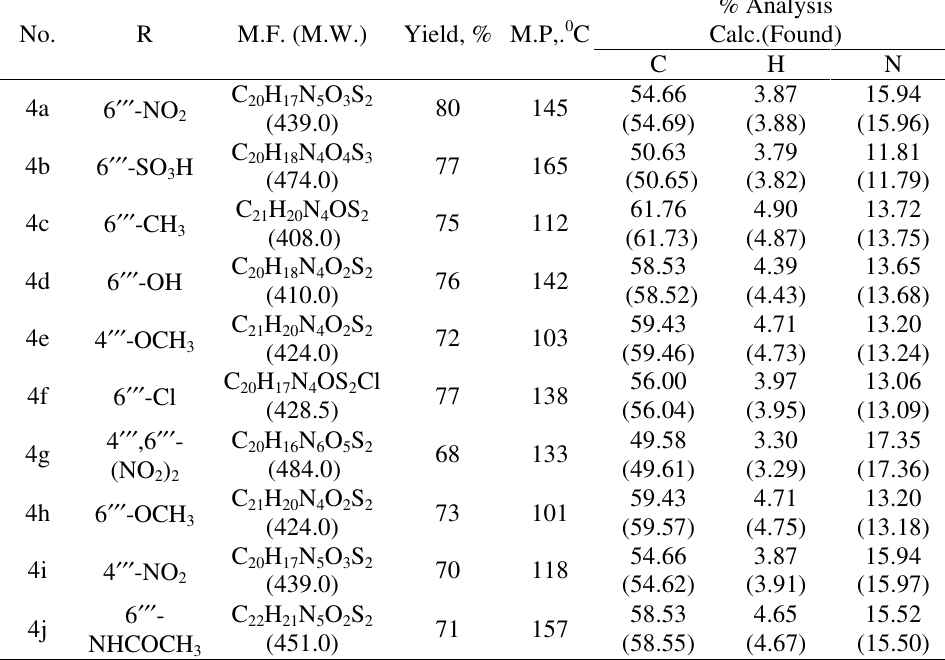
Table 1. Characterization data of compounds